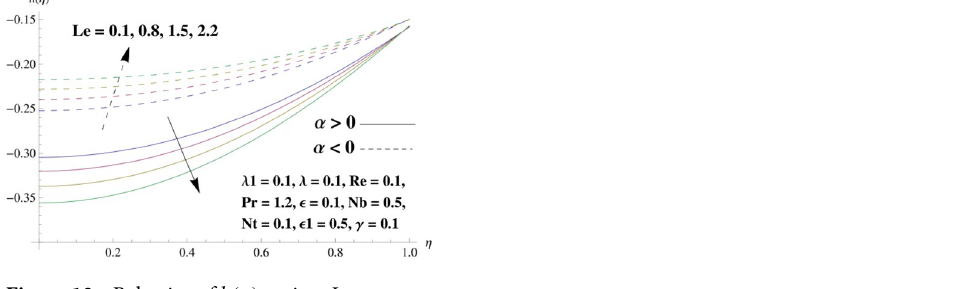
Figure 13. Behavior of h (η) against Le .